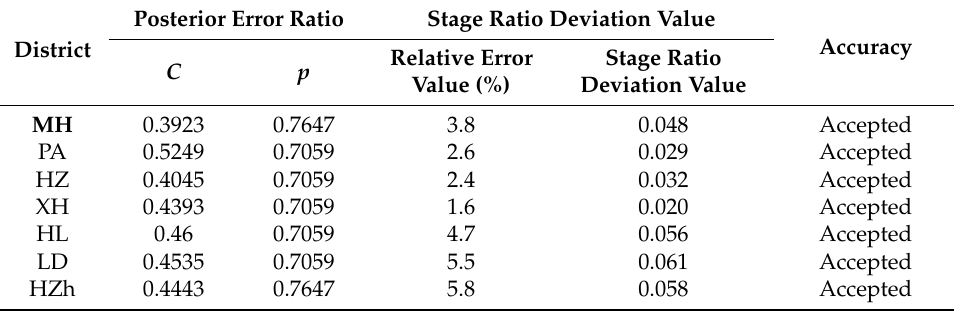
Table 3. Model accuracy test